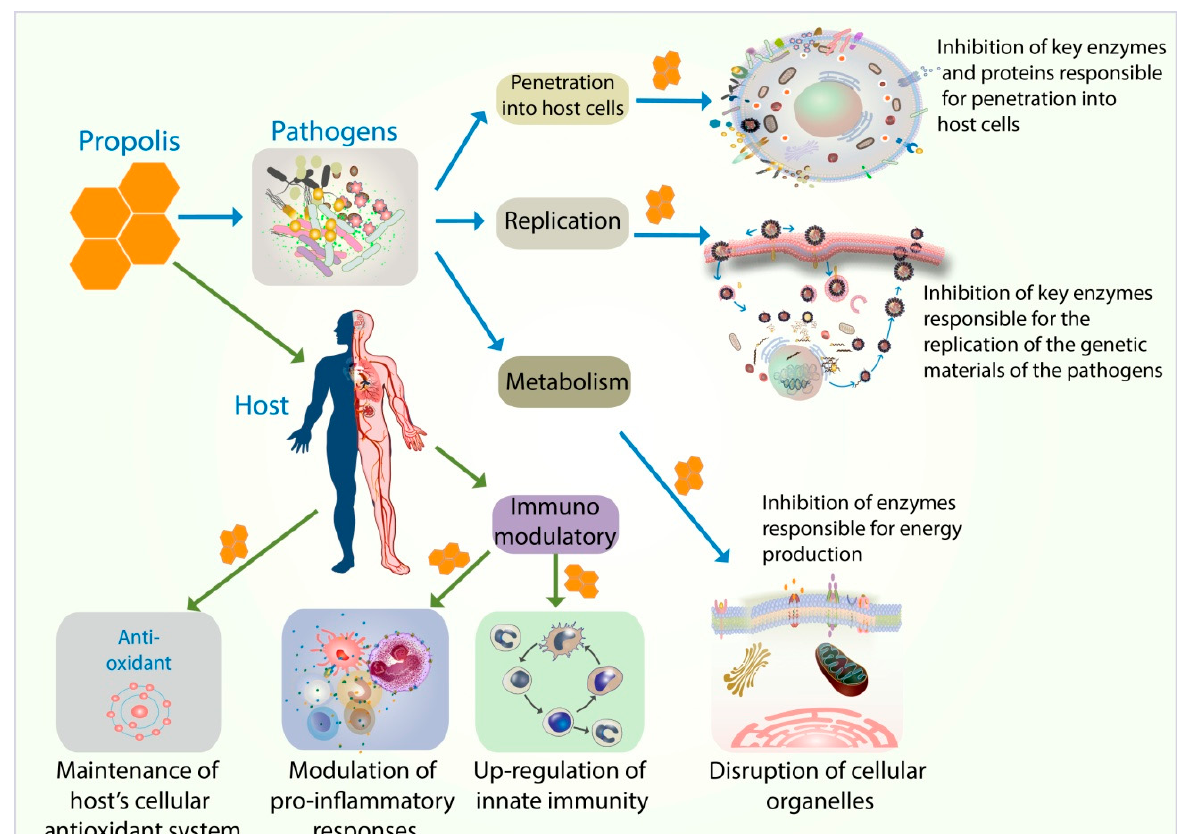
Figure 1. There are two distinct impacts with regards to antimicrobial and anti-parasitic properties of propolis; on the pathogens and on the host. With regards to the pathogens, propolis acts by inhibiting the ability of the pathogens to invade the host cells (by forming a physical barrier and inhibiting enzymes and proteins needed for invasion into the host cells). In addition, propolis inhibits the replication process of the pathogens by inhibiting the enzymes needed for the replication of the pathogens’ genetic materials. Propolis also inhibits the metabolic processes of the pathogens by disrupting cellular organelles and components responsible for energy production. With regard to the host, propolis acts as an immunomodulator. It upregulates the innate immunity and modulates the inflammatory signaling pathways. Propolis also helps maintain the host’s cellular antioxidant status throughout the infection.